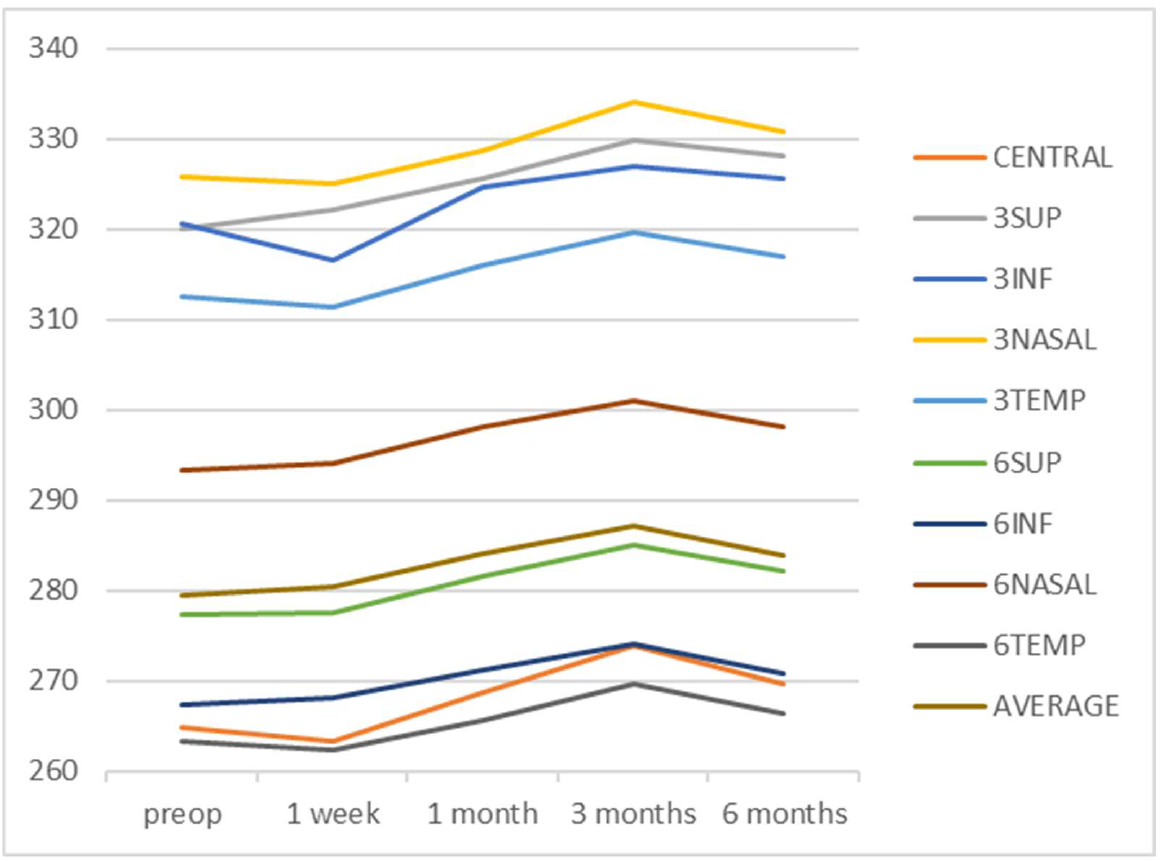
Figure 1. Temporal evolution of the mean macular thickness in the different ETDRS grid areas. The thickness measurements are expressed in microns. Abbreviations: CENTRAL is the central 1 mm ring; 3SUP, 3INF, 3NASAL, and 3TEMP are, respectively, the superior, inferior, nasal, and temporal quadrants of the 3 mm ring in the ETDRS grid; 6SUP, 6INF, 6NASAL, and 6TEMP are, respectively, the superior, inferior, nasal, and temporal quadrants of the 6 mm ring in the ETDRS grid; MV is the macular volume and AVERAGE is the average retinal thickness.